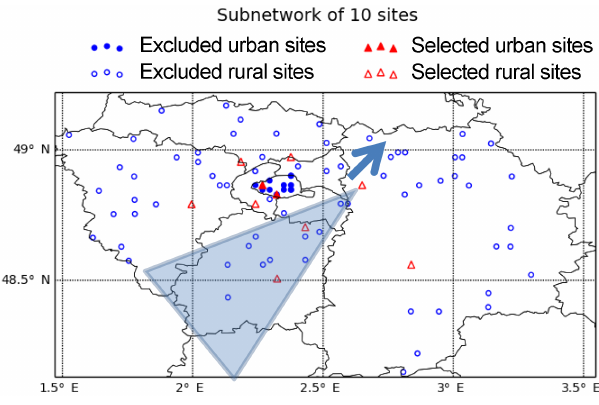
Figure 4. Selection of a subset of 10 sites (red triangles) from a cloud of candidate locations for the R network to form smaller net- works. The blue circles show the sites that are not selected from available locations. The open circles/triangles present rural sites, and the filled circles/triangles present urban sites. This figure also shows how the wind direction selects candidates of upwind sites for concentration gradient computations at a downwind station. The blue arrow indicates the wind direction at that downwind sta- tion. The two red triangles covered in the shadow area are candi- date upwind sites according to the selection procedure detailed in Sect.